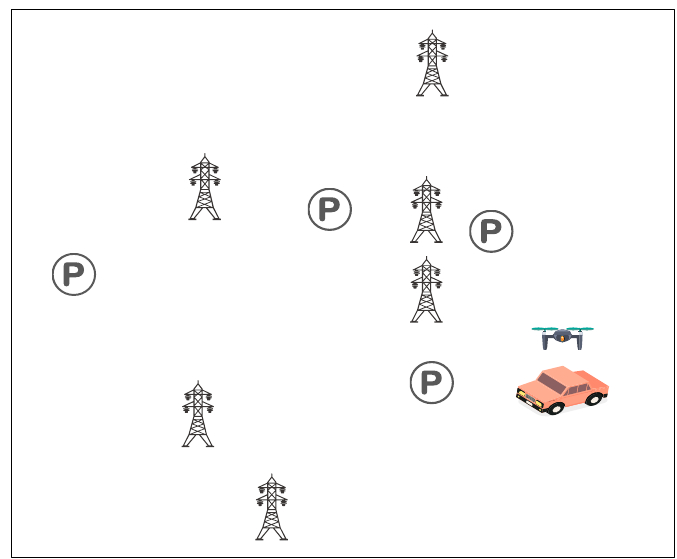
Figure 12. Distribution of the task and parking points in a small-scale test.